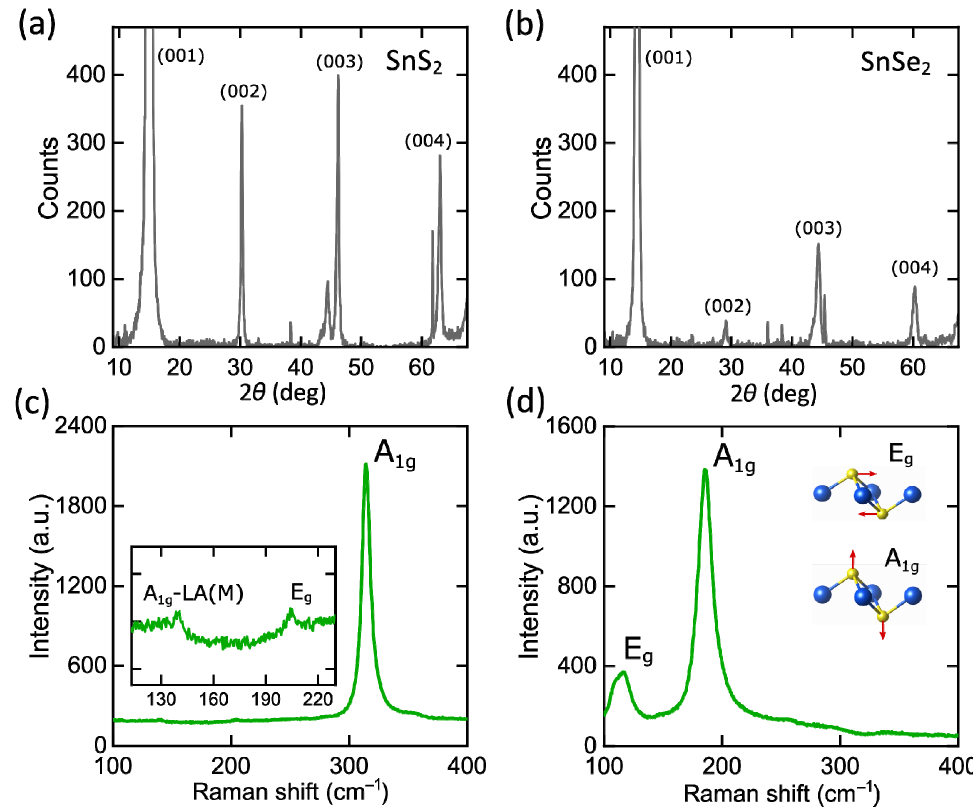
Figure 2. Structural characterization of SnS 2 and SnSe 2 . XRD patterns of ( a ) SnS 2 and ( b ) SnSe 2 . Raman spectra for ( c ) SnS 2 and ( d ) SnSe 2 thin films.